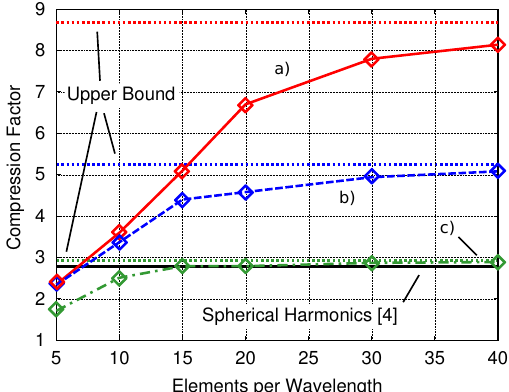
Figure 6: Compression factor versus mesh density for three different geometries: a) square plate, b) dihedral corner and c) cube, see Fig. 4. Dashed line: upper bounds for the compression rate given by Eq.